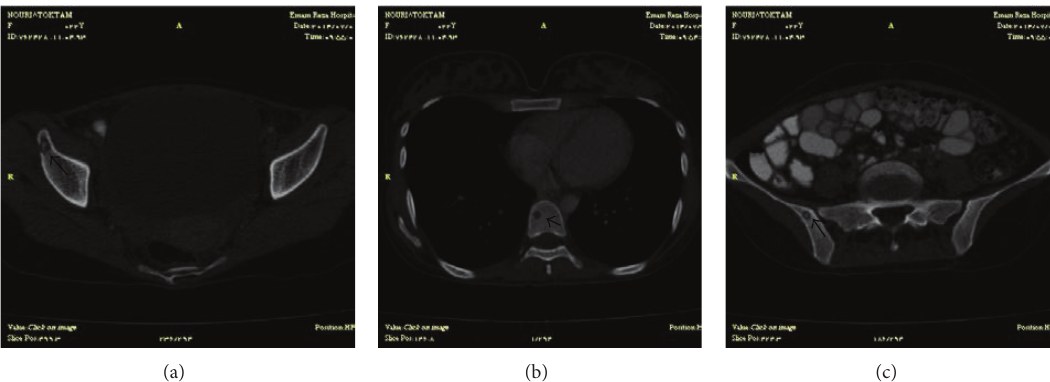
Figure 1: Computed tomography scan shows multiple small osteolytic lesions containing a sequestrum in acetabular roof (a), 8th thoracic vertebra (b), and ilium (c).